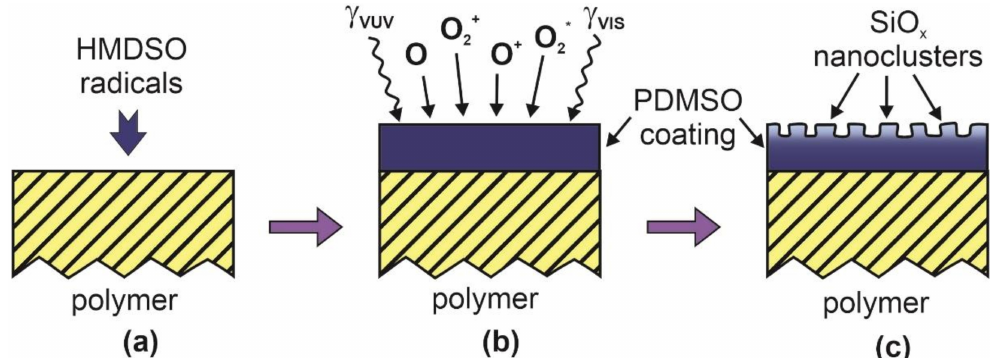
Figure 3. Schematic of a method for hydrophilization of polymers by deposition of a thin polydimethyl siloxane (PDMSO)-like coating followed by oxygen plasma treatment. ( a ) Polymer exposure to hexamethyl disiloxane (HMDSO) radicals to deposit PDMSO-like coating, ( b ) treatment of PDMSO-like coating in O 2 plasma, and ( c ) etching of organic part of PDMSO and formation of nanostructured SiO 2 -like